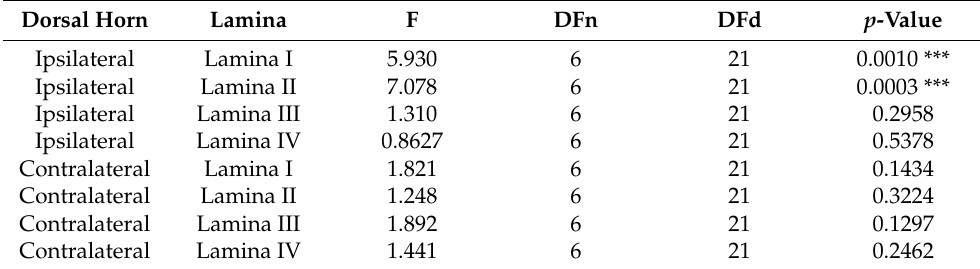
Figure 4. CCI induces a significant increase in the proportion of astrocytes and microglia in ipsi-lateral dorsal horns reversed by the MOR and DOR agonist LP2. ( a – f ) Representative pictures of Gfap- ( a ) and Iba1- ( d ) positive cell and quantification on laminae I-IV of the ipsi-lateral ( b , e ) and contra-lateral ( c , f ) dorsal horn of the lumbar region of the spinal cord. CCI, chronic constriction injury; NLX, naloxonazine; NTD, naltrindole; FC, fold change. * p -value < 0.05, ** p -value < 0.01, and *** p -value < 0.001 versus sham or between groups. Table 1. ANOVA table for Gfap-positive cells per